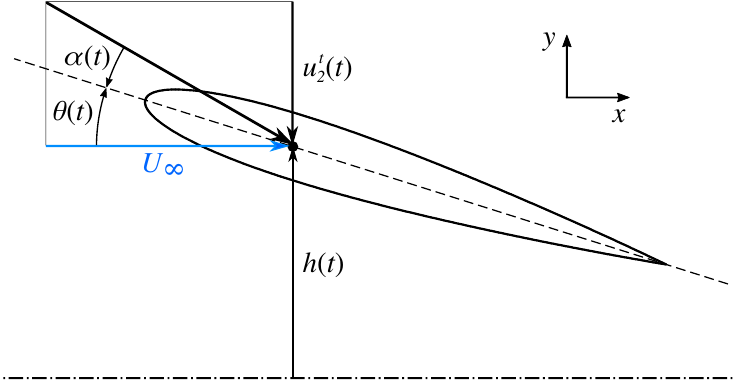
Figure 1. Scheme of the NACA0012